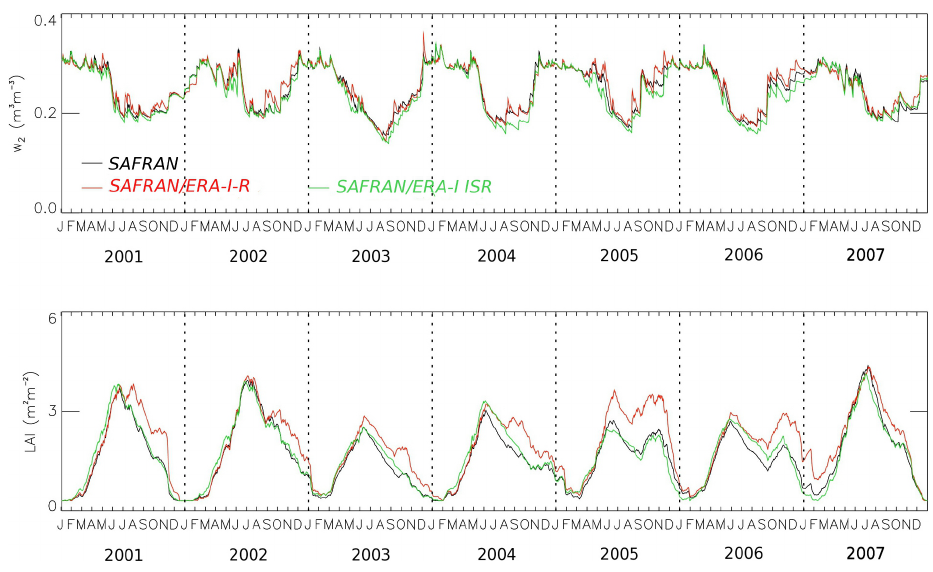
Fig. 12. As in Fig. 11, except for SAFRAN with ERA-I-R precipitation and SAFRAN with ERA-I ISR